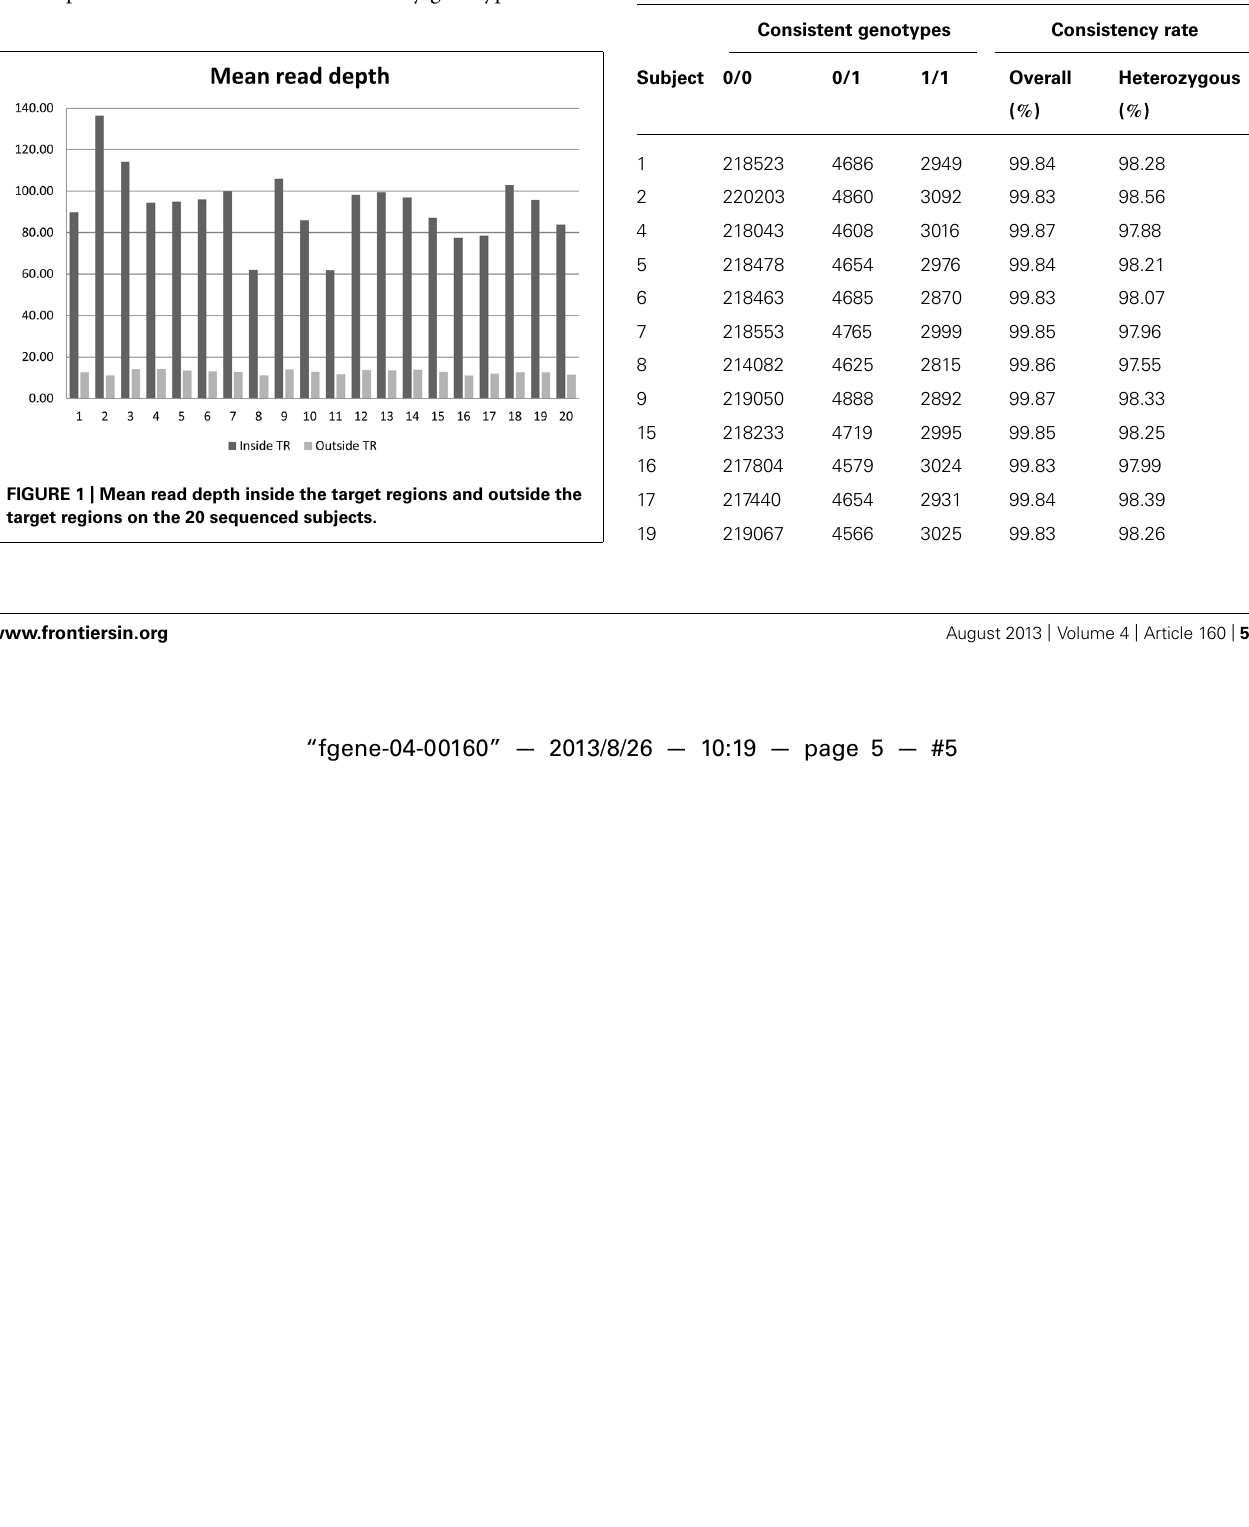
Table 1 . The overall consistency rate with array-based variant calls